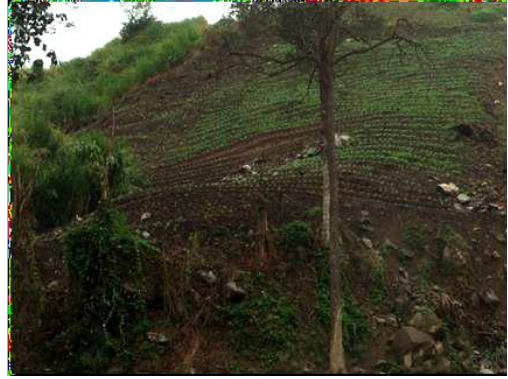
Figure 15. Landslide body been used as agricultural area